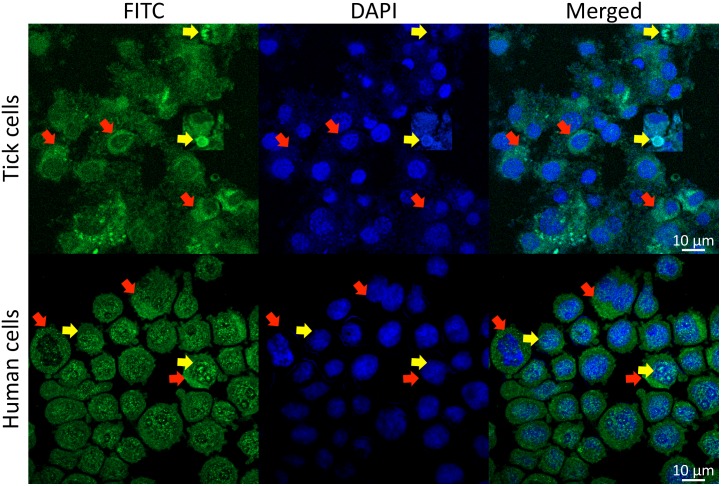
Subcellular localization of Subolesin/Akirin2. Representative images of immunofluorescence analysis of I. scapularis ISE6 and human HL60 cells incubated with anti-Subolesin and anti-Akirin2 antibodies, respectively. The cells were fixed with 4% paraformaldehyde in PBS for 15 min, permeabilized with 0.5% Triton X-100 in PBS for 5 min and blocked with blocking buffer (3% BSA in PBS) for 1 h. Then, the cells were incubated overnight at 4°C with anti-Subolesin (Antunes et al., 2014) or anti-Akirin2 (Abcam, Cambridge, United Kingdom) antibodies (1/50 dilution in 3% BSA in PBS). After 3 washes with PBS, the slides were incubated with fluorescein isothiocyanate (FITC) conjugated anti-rabbit secondary antibodies (Sigma-Aldrich, St. Louis, MO, United States; green) at 1/160 dilution in 3% BSA in PBS for 1 h at room temperature. Cells were counterstained with ProLong Antifade containing 4′,6-diamidino-2-phenylindole (DAPI) (Molecular Probes, Eugene, OR, United States; blue), and imaged with a Zeiss LSM800 confocal microscope using a 63× oil immersion lens (Carl Zeiss, Oberkochen, Germany). Yellow arrows show examples of protein localization in the nucleus while red arrows illustrate protein localization in the cytoplasm.